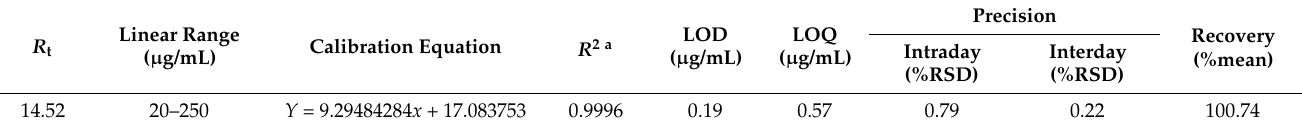
Table 2. Validation report of the method for rutin ( 6 ) determination in C. guatemalensis .